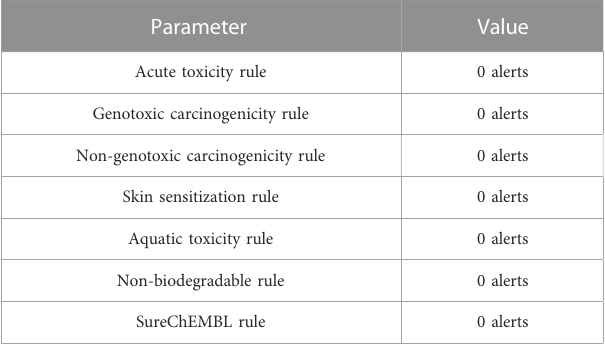
TABLE 7 Toxicophore based pro fi le of 4-hydroxy isoleucine calculated with ADMETLab 2.0.